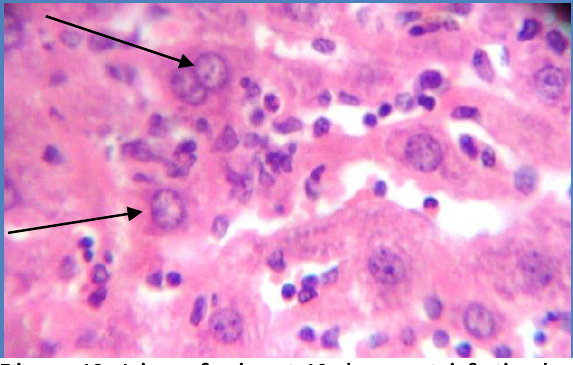
Figure, 12: Liver of mice at 10 days post infection by Candida albicans and treated with 20% of Datura stramonium extract ( ) shows neutrophils in the liver sinasoid. (Heamatoxcyline and Eosin stain 40X).